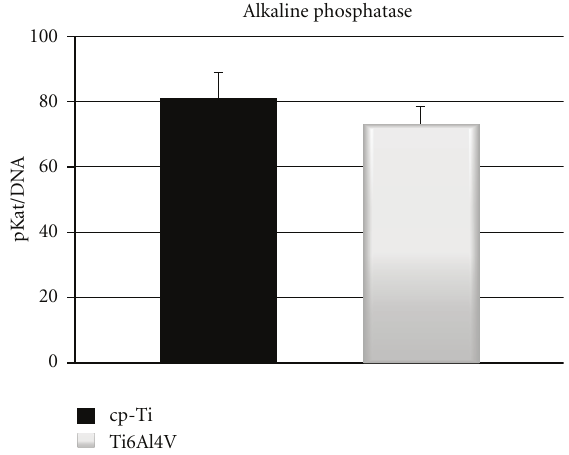
Figure 6: Histograms showing the ALP activity for both constructs after 10 days of culture.